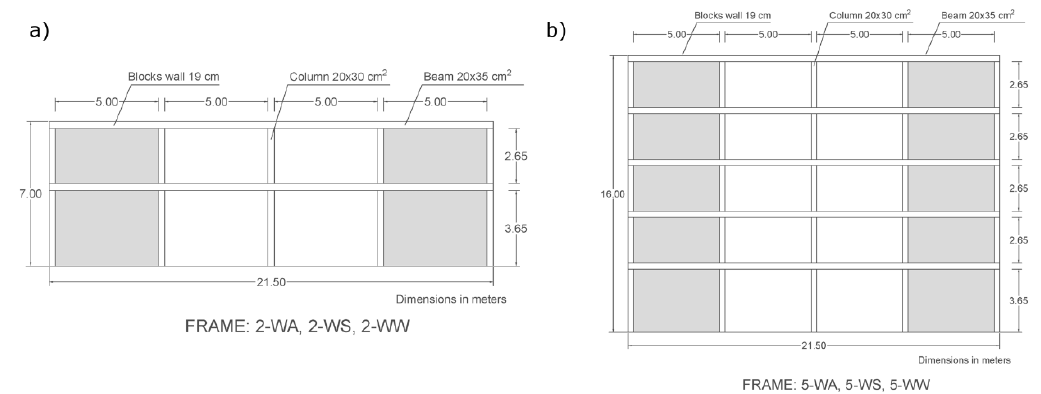
Figure 6. Frames considered in the analysis: ( a ) 2-storey frame; ( b ) 5-storey frame.